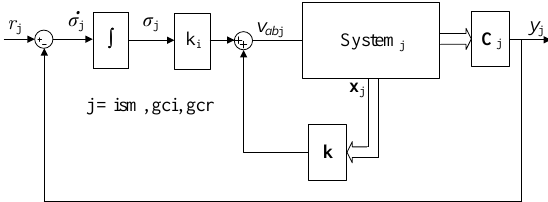
Figure 4. Block diagram of the